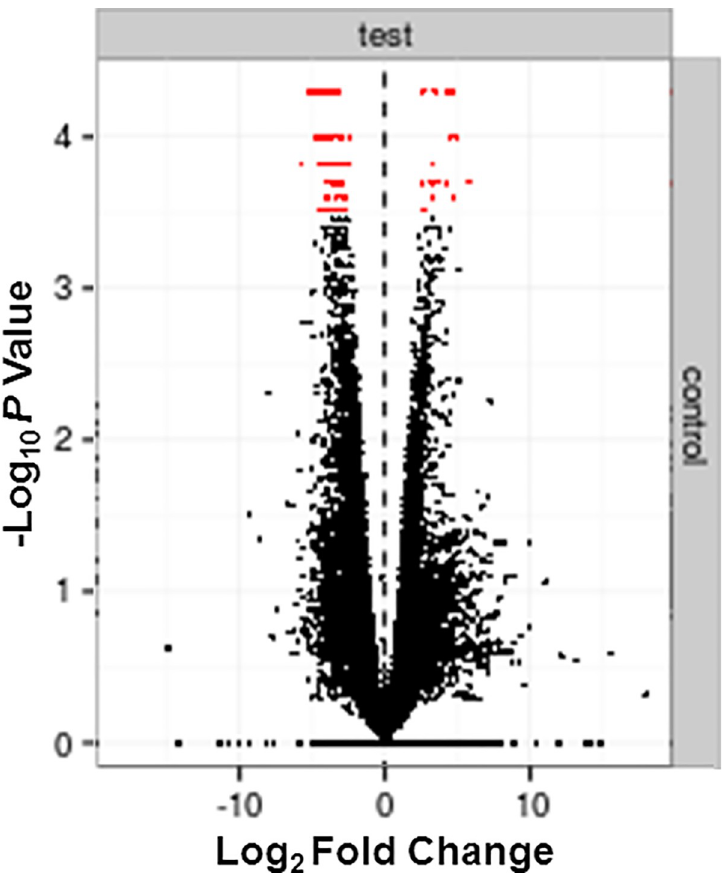
Fig 9. Volcano plot indicating the significantly imbalanced (in red) genes in logarithmic fold of RPKM. We identified a total of 24 over-expressed genes on the right of the dotted line, and 62 under-expressed genes on the left.